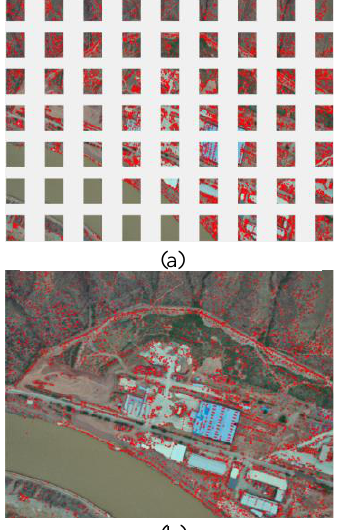
(b) Figure 3. Interest point extraction by the partition-based FAST detector. (a)Non-overlapping grids based on the partition scheme. (b) Evenly distributed interest points in the image.